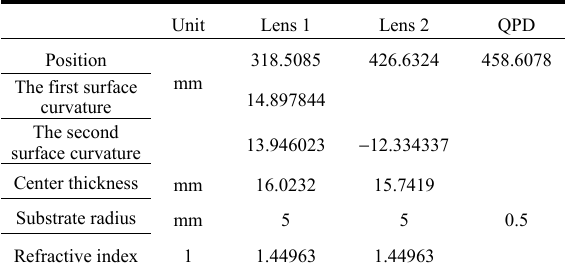
Table 4 Parameters of imaging